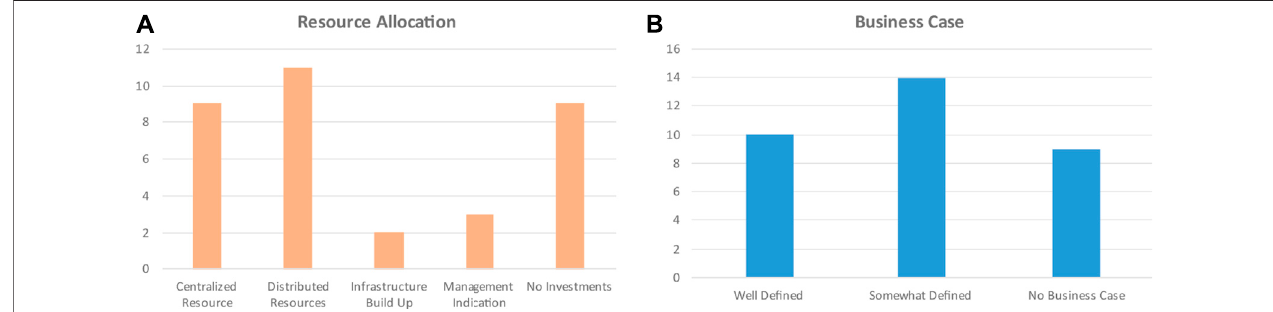
FIGURE4| Perceivedcostvsbene fi tofthedigitaltransformation; (A) illustrateshowresourcesareallocated; (B) illustratesthebusinesscase(economicbene fi t)of